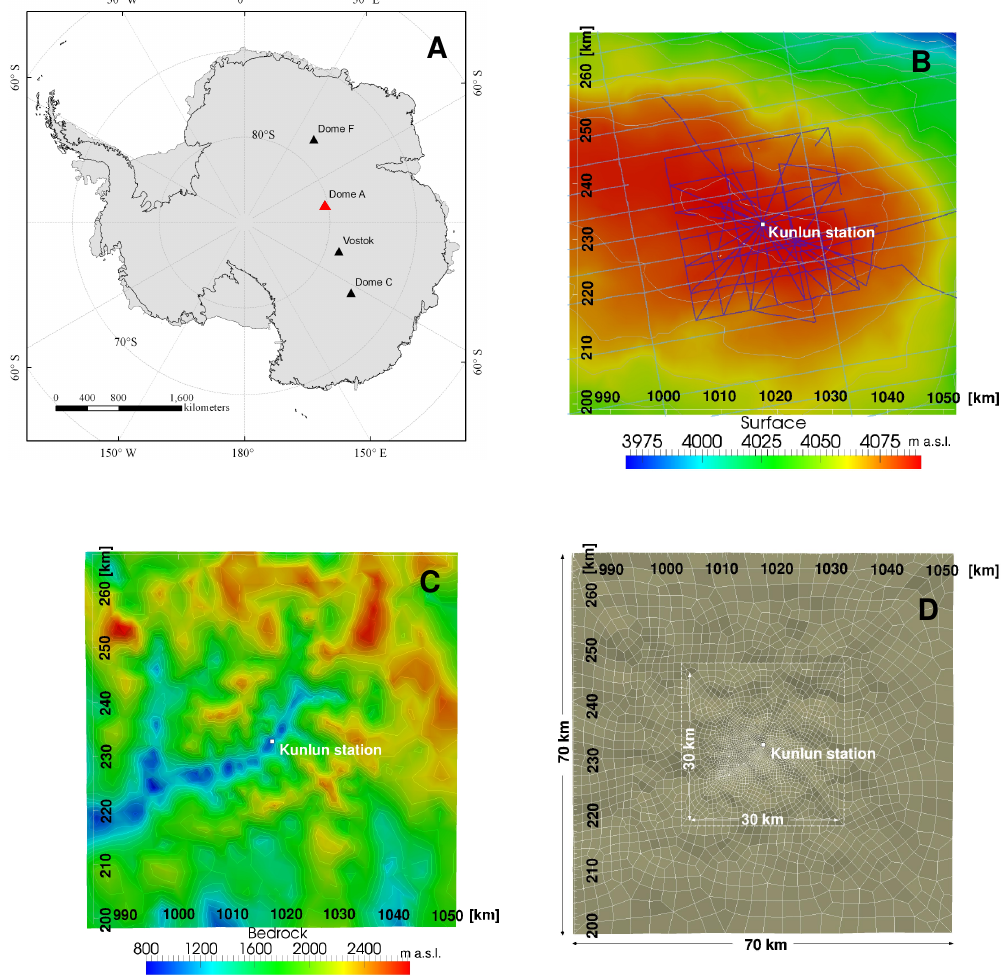
Figure 1. (A) Map of Antarctica with locations of Dome A, Dome C, Dome F and Vostok; (B) surface topography in the vicinity of Dome A and Kunlun station (contour spacing 10m), black lines show ground-based radar surveys, grey lines are airborne radar lines; (C) bedrock topography (contour spacing 200m); and (D) the finite element mesh in the 70 × 70km 2 domain, with higher resolution in the central 30 × 30km 2 region. The coordinate system is WGS 1984 plotted using Antarctic Polar Stereographic with standard parallel at 71 ◦ S and central meridian at 0 ◦